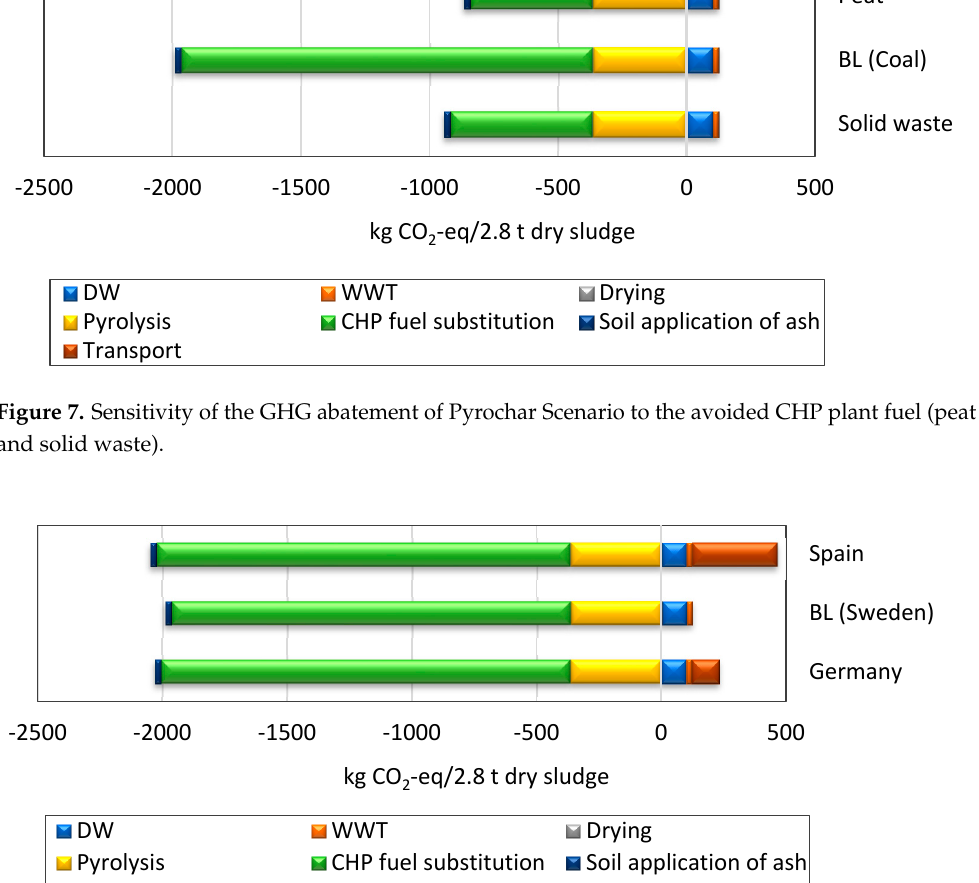
Table 2. The optimal condition for each parameter considered in the sensitivity analysis (See SI for the results of the last six items). Parameter